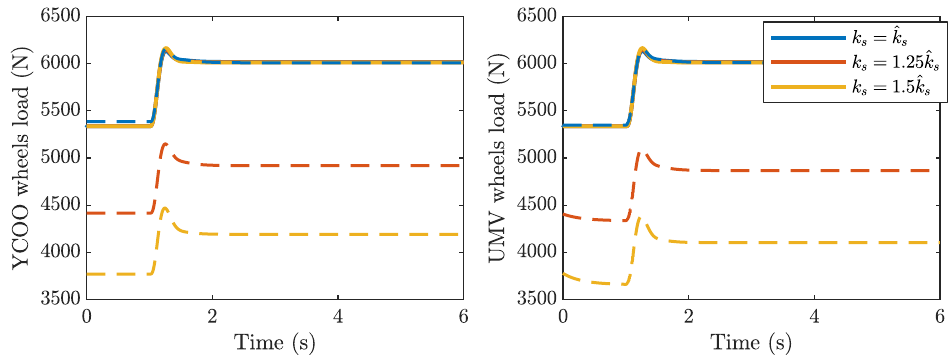
Figure 8. Robustness against suspension stiffness during a braking maneuver. Solid lines show the ground-truth signals and dashed lines show the estimated ones.